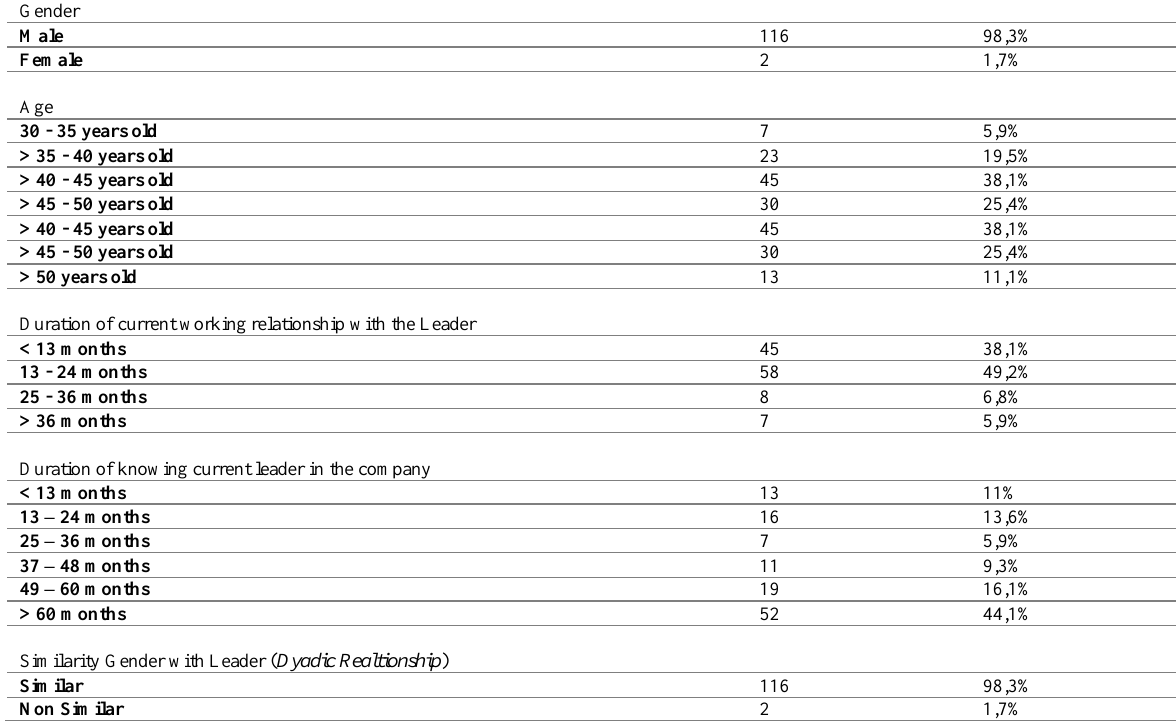
Table 3: Frequency and Profile’s Percentage of Respondents Project